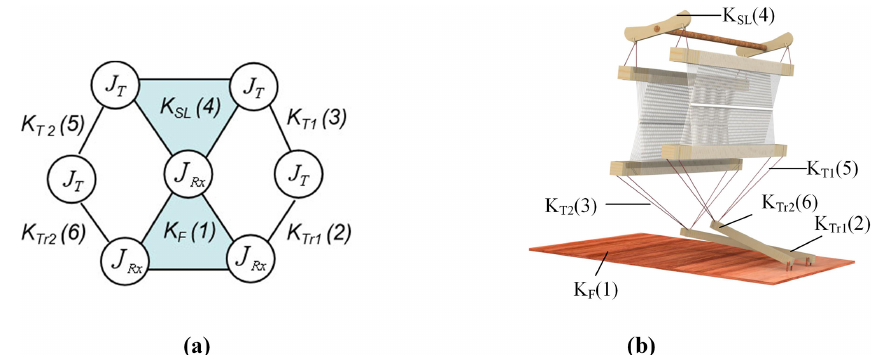
Figure 9. Chain and simulation drawing of treadle heddle-lifting